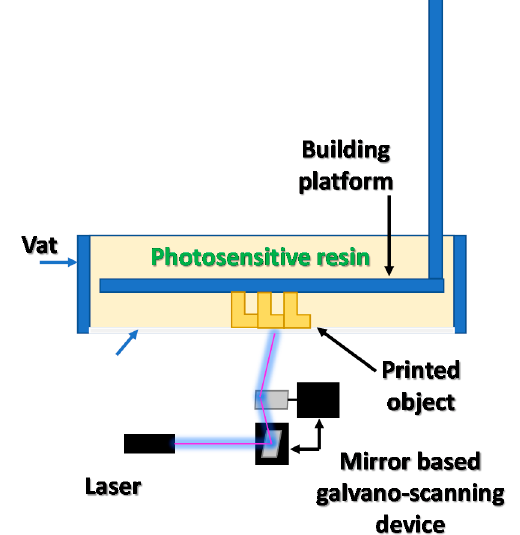
Figure 3. The modern design of the stereolithography system with a light-permeable membrane at the bottom of the resin vat.